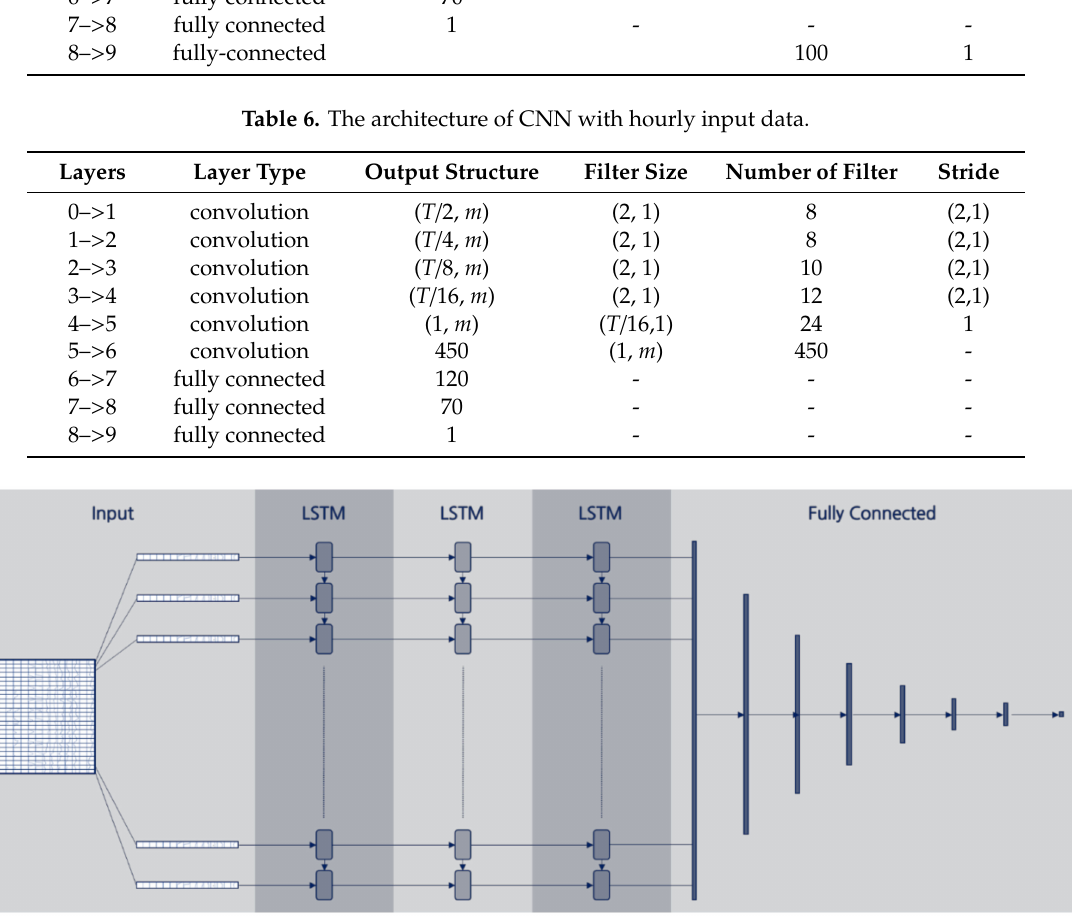
Figure 1. Model structure of long-short term memory (LSTM) for temperature forecasting.